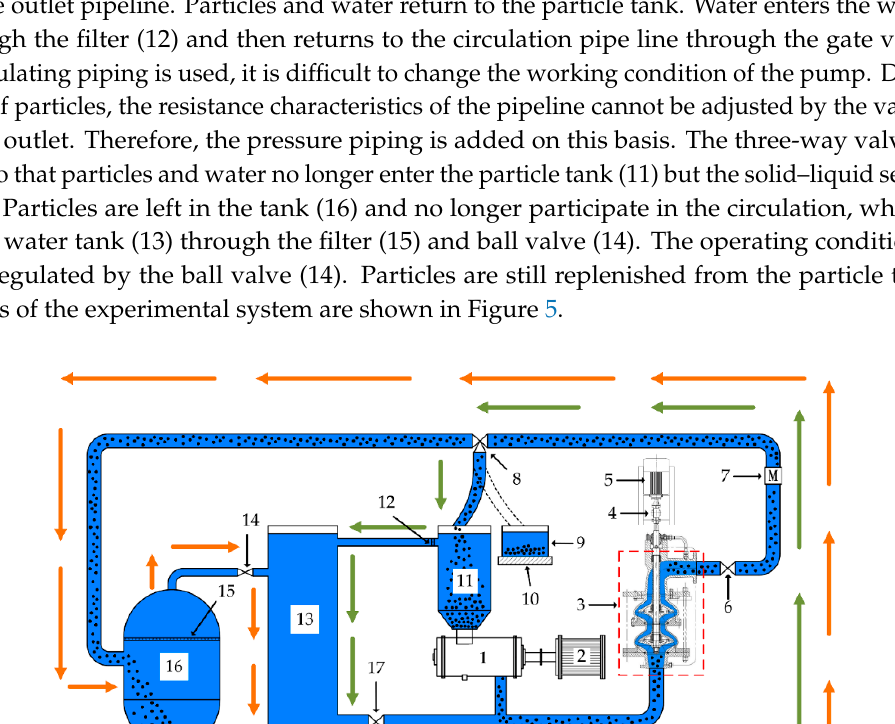
Figure 3. The calculation grid of the slurry transport pump.